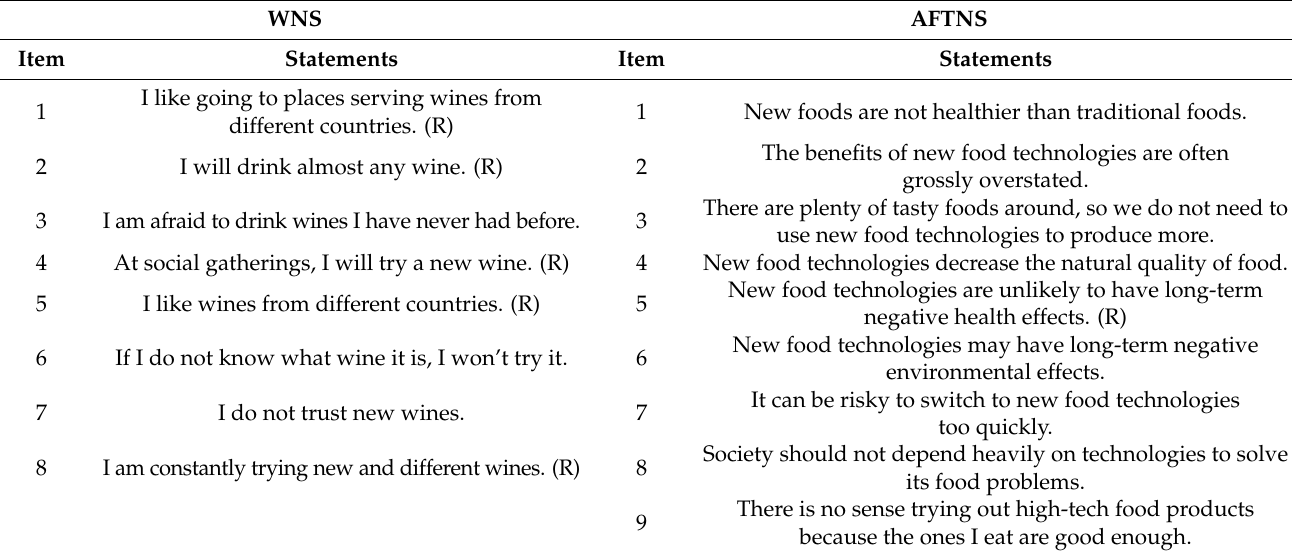
Table 2. Items from the Wine Neophobia Scale (WNS) and the Abbreviated Food Technology Neophobia Scale (AFTNS). WNS